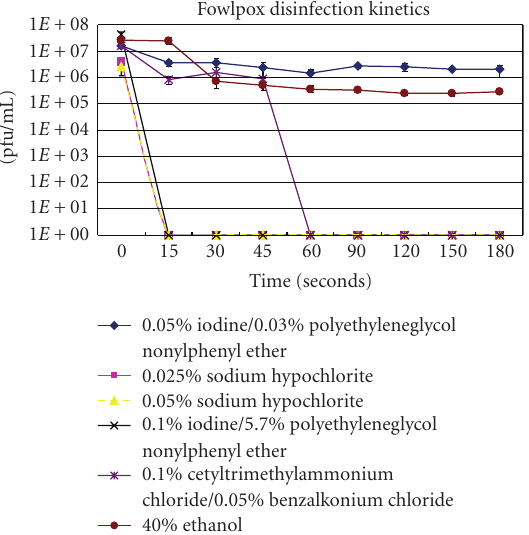
Figure 1: The inactivation kinetics of vaccinia virus following treatments with low concentrations of four di ff erent chemicals.